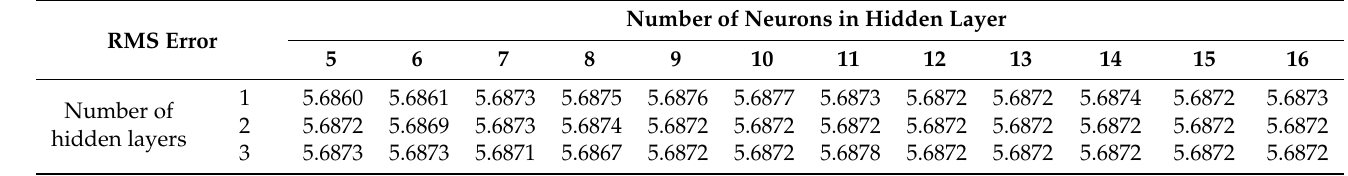
Table 15. RMS error for active power loss estimation for IEEE-34 bus system (case